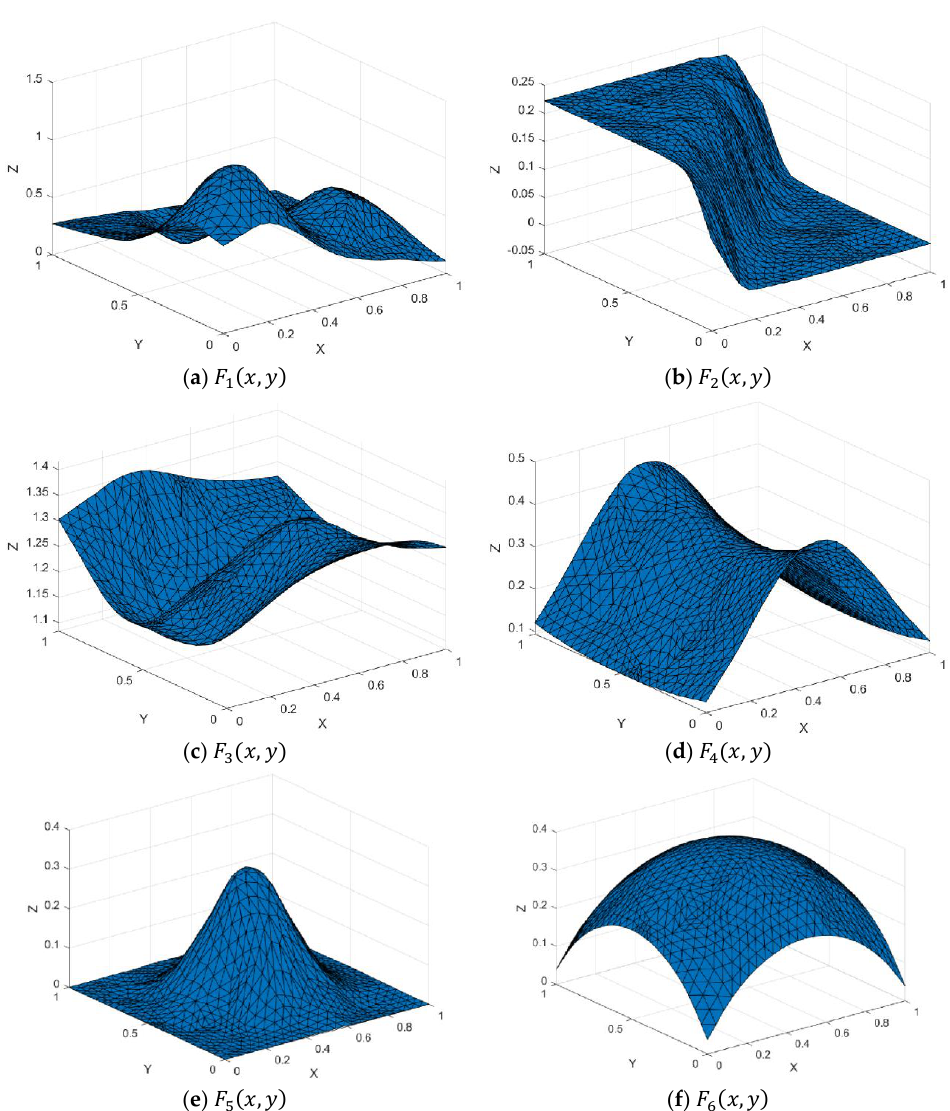
Figure 21. Surface interpolation using Goodman and Said method and Choice 2 for 100 datasets.